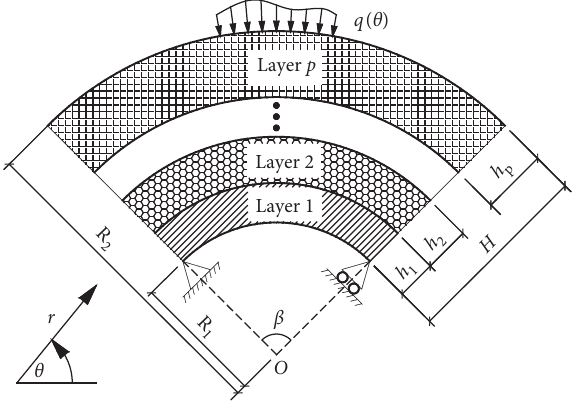
Figure 2: Simply supported sandwich FGM